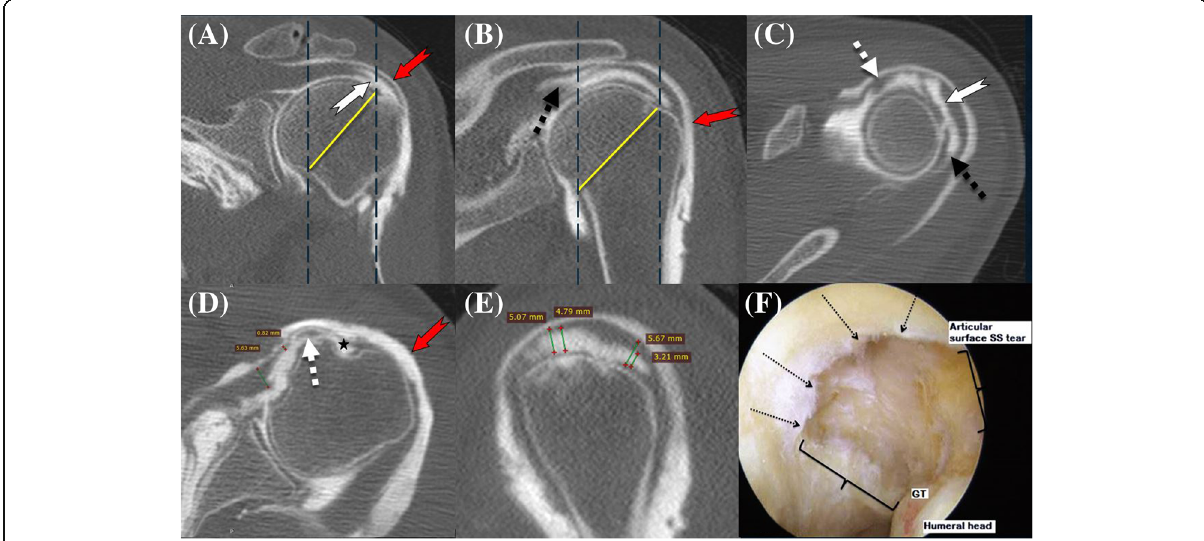
Fig. 3 A 53 years old female patient complained from long - standing left shoulder weakness and pain increased on lifting or rotating her arm. Coronal oblique CT arthrographic images ( a , b ) demonstrate intermediate articular surface supraspinatus tendon tear (white arrow) and medial articular surface infraspinatus tendon tear (dashed black arrow). Axial ( c , d ) images show complexity and irregularity of both tears; the subscapularis tendon shows extensive partial thickness tear with dislocated biceps lone head tendon (dashed white arrow) and empty biceptal groove (star). Sagittal oblique ( e ) image show how contrast within the SA-SD bursa could highlight the bursal surface of the rotator cuff allowing for accurate measurement of thickness of the tear. Arthroscopic image ( f ) demonstrates large articular surface tear (area between brackets) through the supraspinatus tendon, with irregular edge